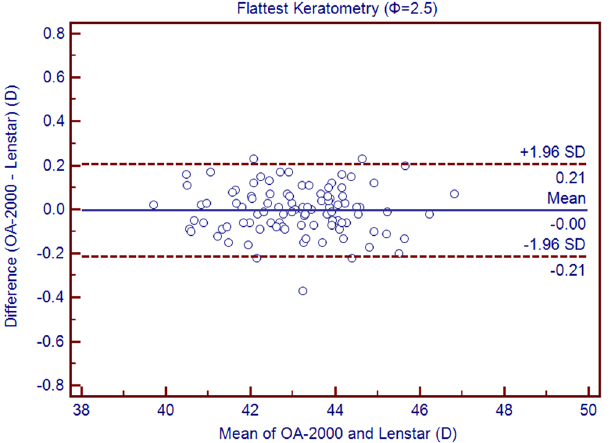
Figure 7. Bland-Altman plots show the agreement between OA-2000 swept-source optical coherence tomography and Lenstar optical low coherence reflectometry for measuring flat keratometry (Kf) at 2.5 mm. Solid lines represent the bias between both devices and dotted lines represent the 95% confidence interval for the difference.